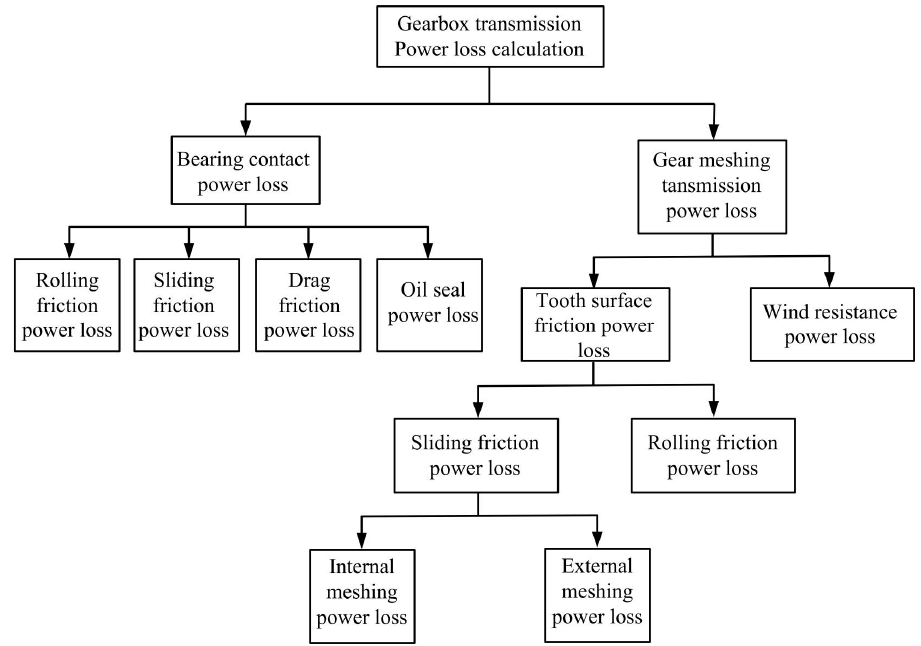
Table 4. Transmission efficiency when power transmitted along the transmission path. Efficiency (%)